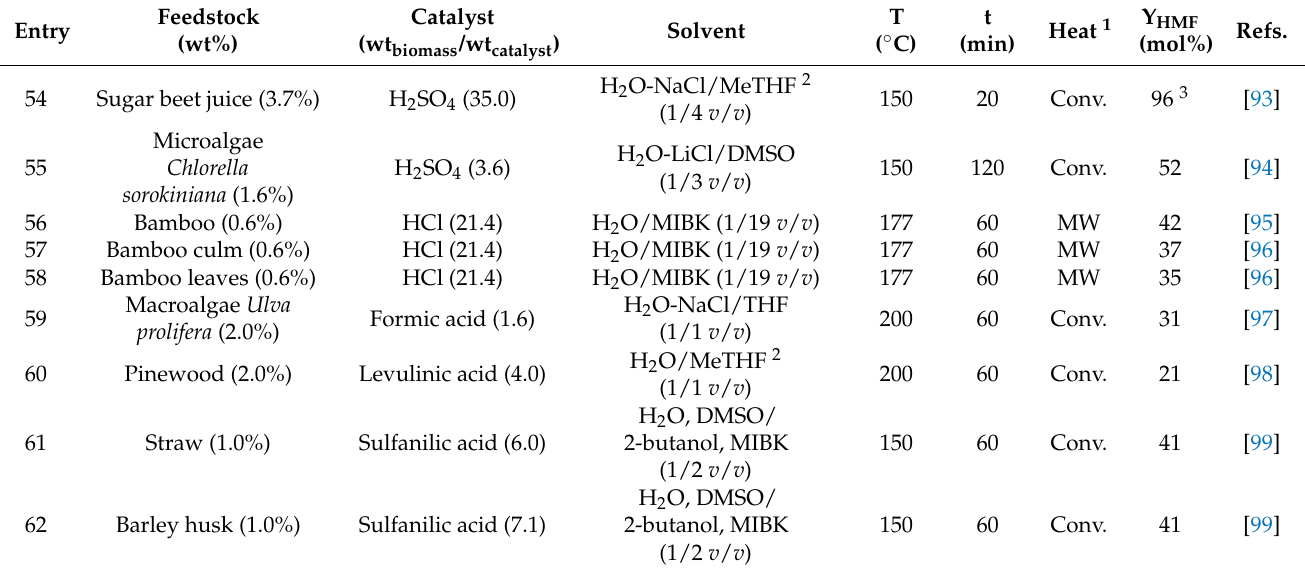
Table 3. HMF production starting from raw biomasses in biphasic and/or multiple-solvent systems with mineral and organic